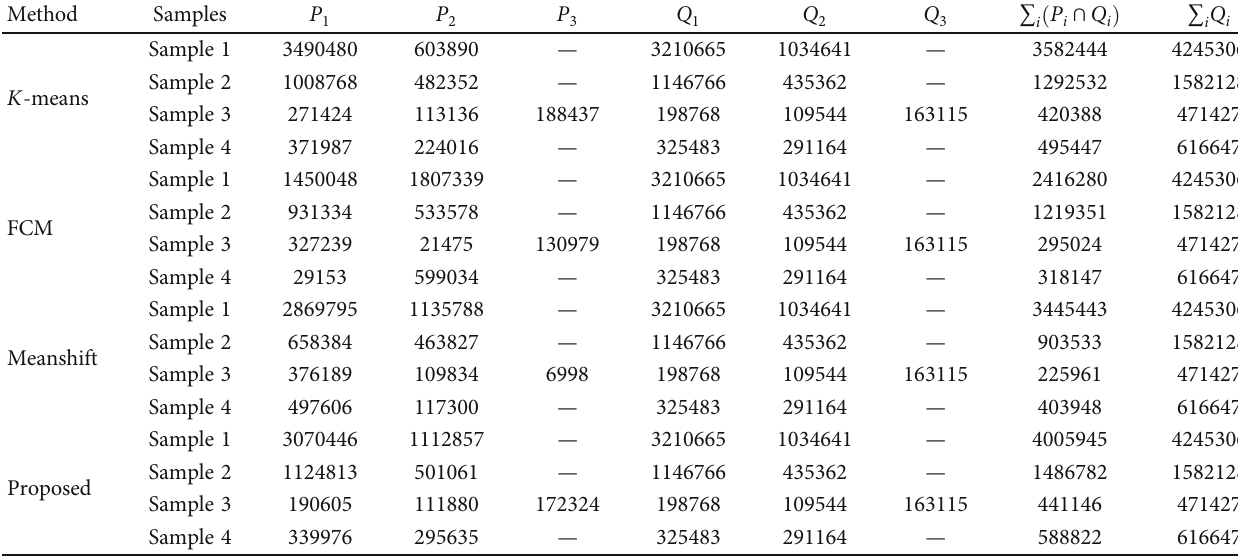
Q Table 4: P i and i of the 4 images under the 4 clustering